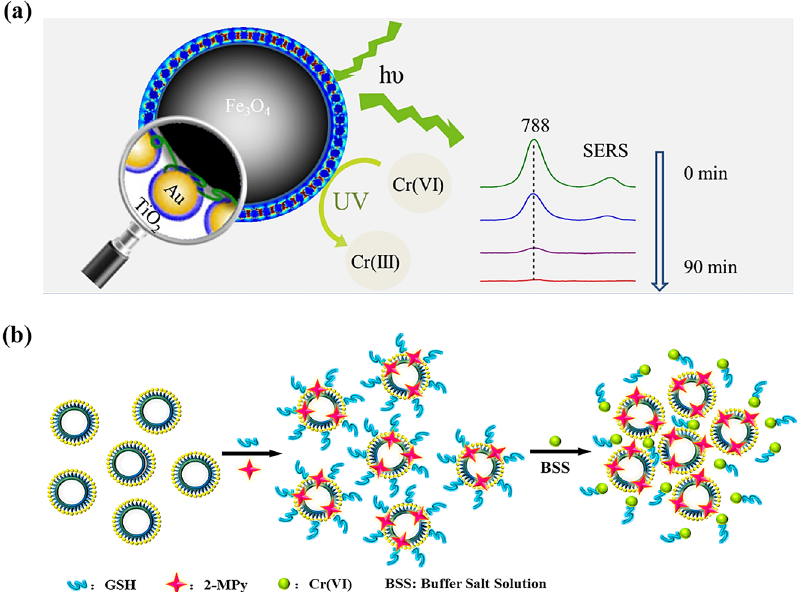
Figure 9: SERS-based chromium(VI) detec-